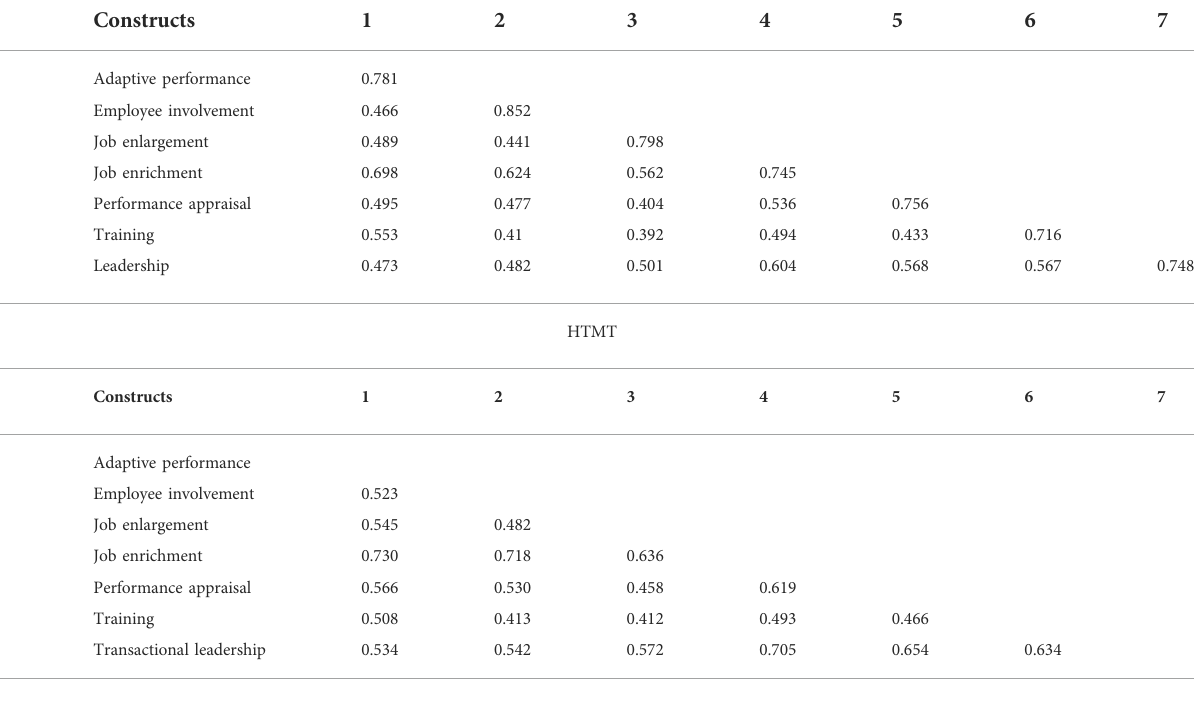
TABLE 2 Discriminant validity: Fornell & Larcker.